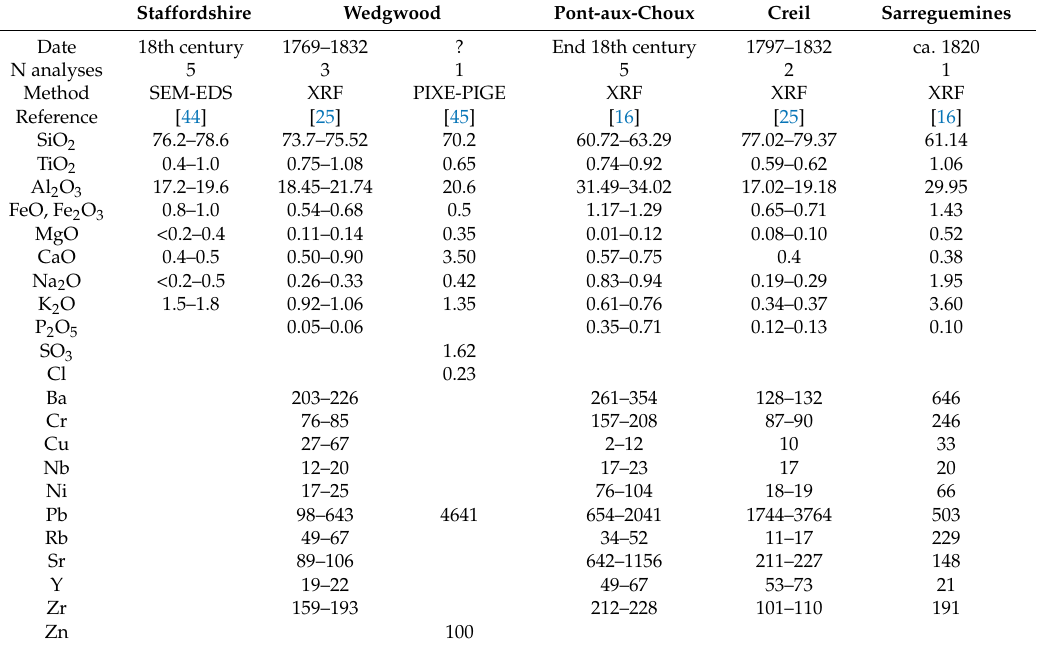
Table 2. Chemical compositions (Min.–Max.) of English and French CaO-poor white earthenwares. Oxides and chlorine in wt %, other elements in ppm. Staffordshire Wedgwood Pont-aux-Choux Creil